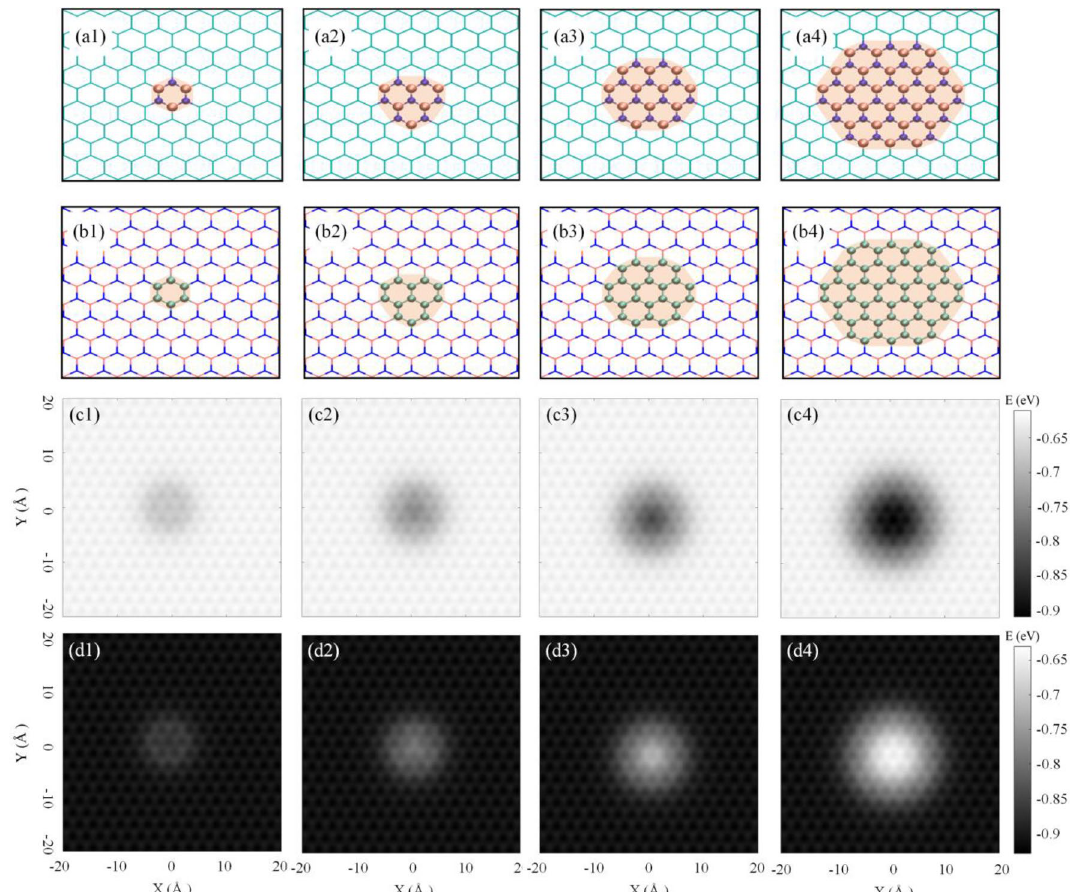
Figure 3. Impurities considered for analysis of potential energy. ( a ) A graphene substrate with 1, 3, 7, and 19 cells (hexagon) impurities of boron-nitride. ( b ) A boron-nitride substrate with 1, 3, 7, and 19 cells impurities of graphene. Each 1, 3, 7, and 19-cell impurity consists of 6, 13, 24, and 54 atoms, respectively. ( c ) The potential energy of the C 60 during the horizontal displacement on the graphene substrate with boron-nitride impurities (a1, a2, a3, and a4 consist of 1, 3, 7, and 19 cells of boron-nitride impurities, respectively) and ( d ) boron- nitride substrate with graphene impurity ( b1 , b2 , b3 , and b4 consist of 1, 3, 7, 19 cells of graphene impurities,